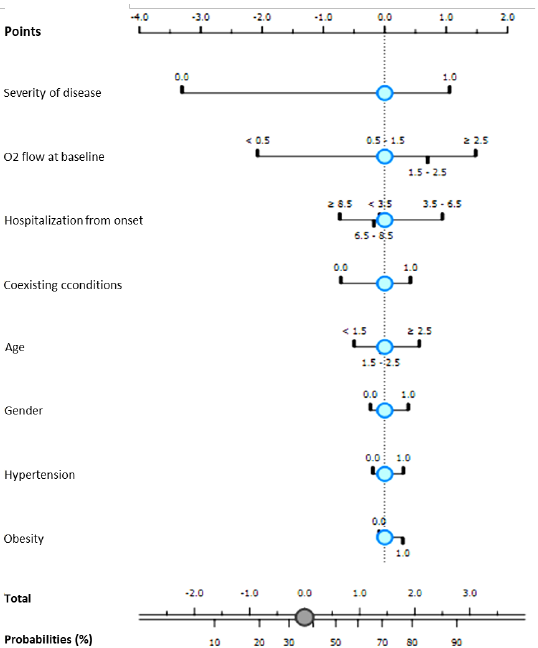
Figure 3. Probability of progression to non-invasive ventilation according to Bayesian classifier (NBC). Patients treated with Remdesivir hospitalized during the second COVID-19 wave (March 2021 – September 2021 — Group B).